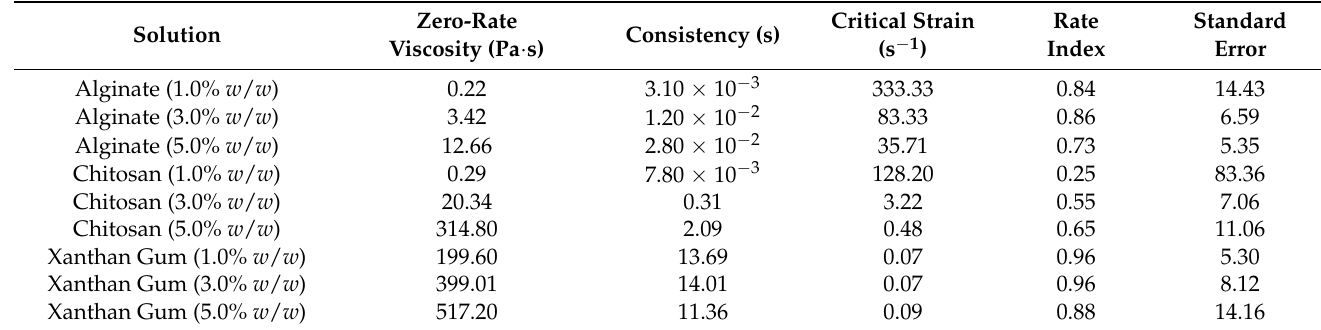
Table 1. Cross fit results (no Laponite ®